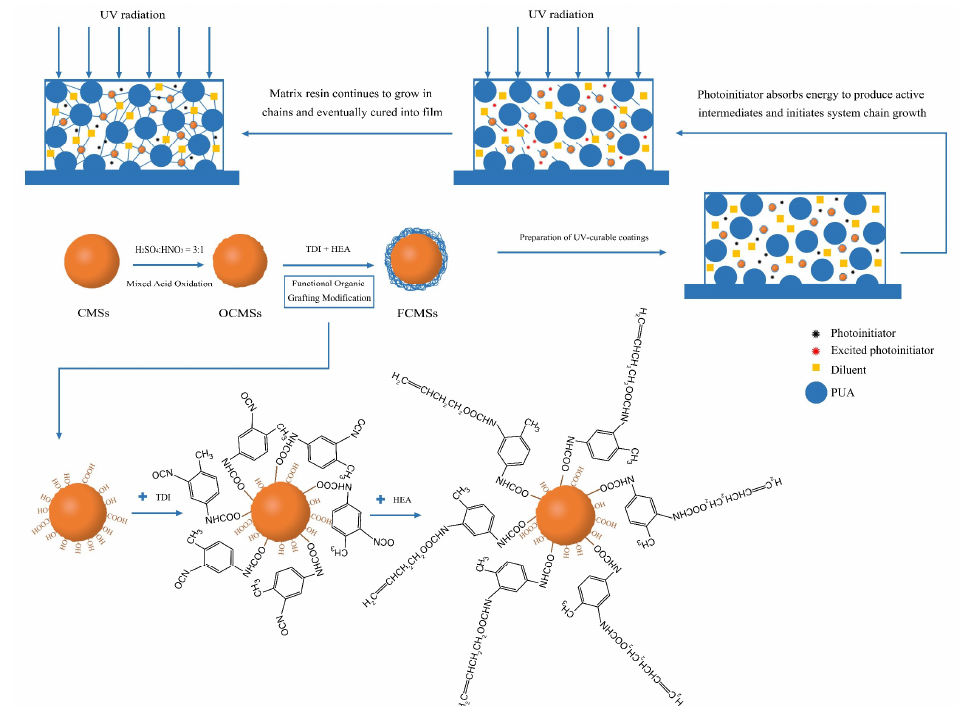
Figure 1. Schematic illustration of the synthesis procedures of functional coated microspheres (FCMs) and UV curing procedure of hydrophobic coatings of functionalized carbon microspheres.